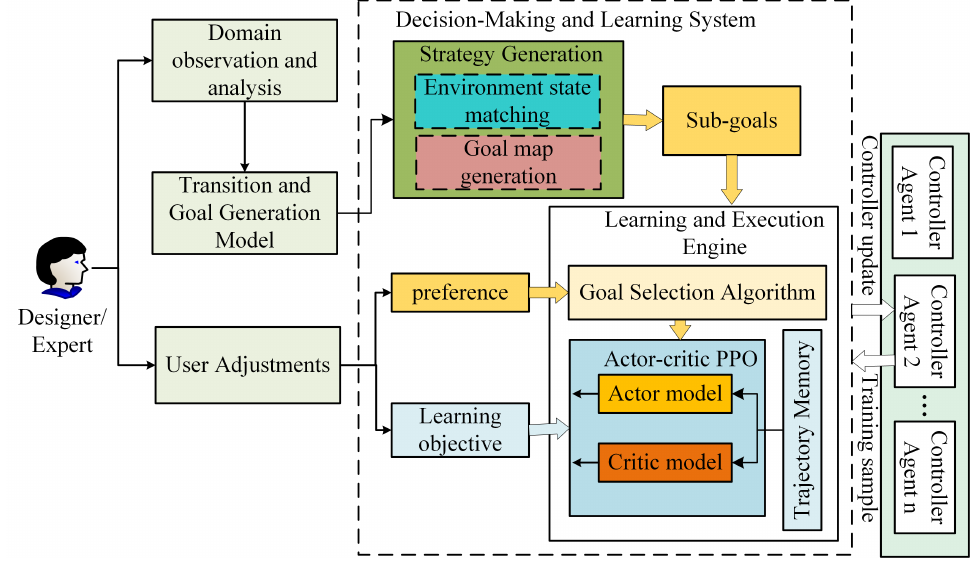
Figure 3. Structure diagram of the proposed